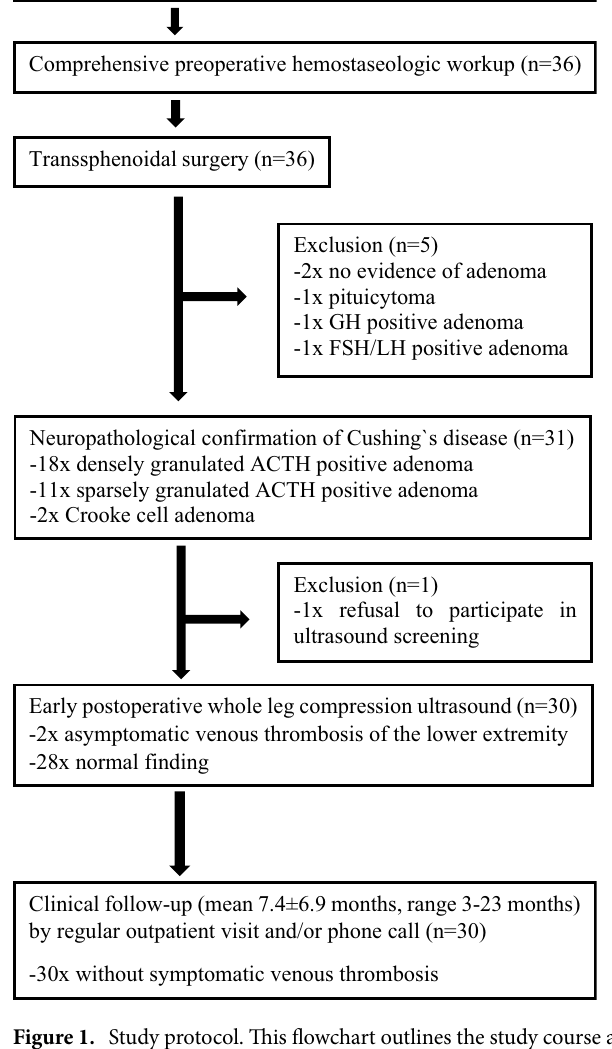
Figure 1. Study protocol. This flowchart outlines the study course along with the associated investigations and the reasons for excluding individual